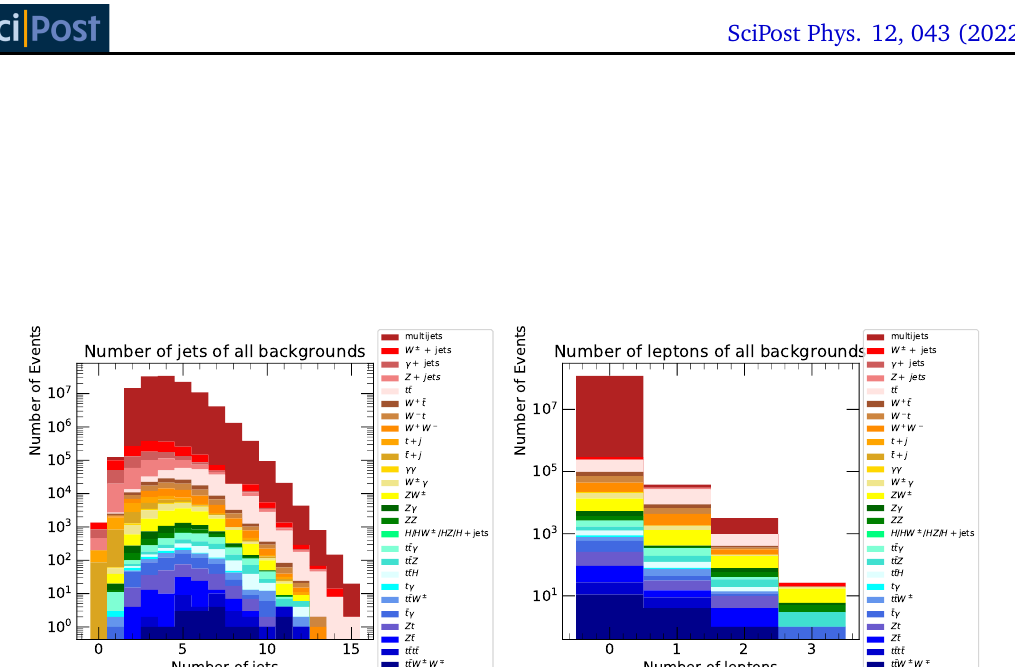
in GeV and azimuthal angle φ